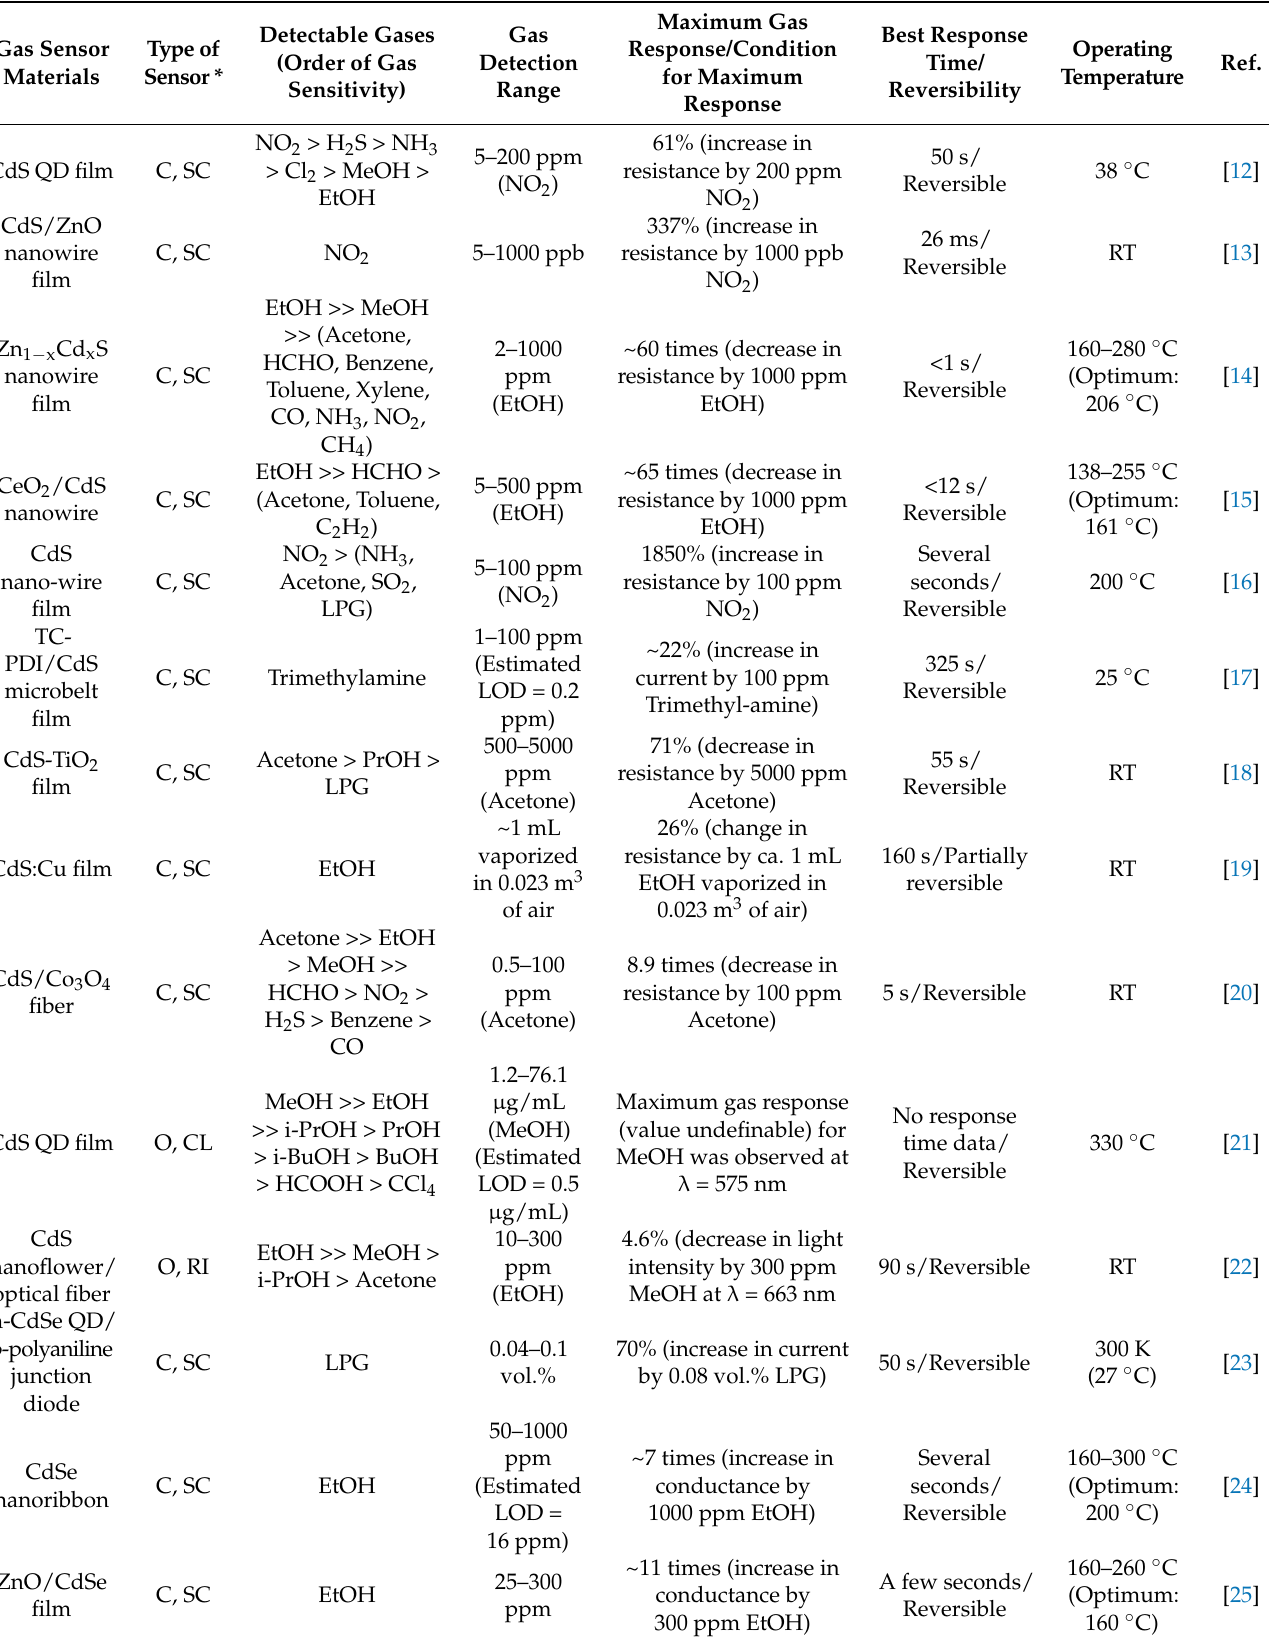
Table 2. Conductometric and optical gas sensors using CdS, CdSe, and